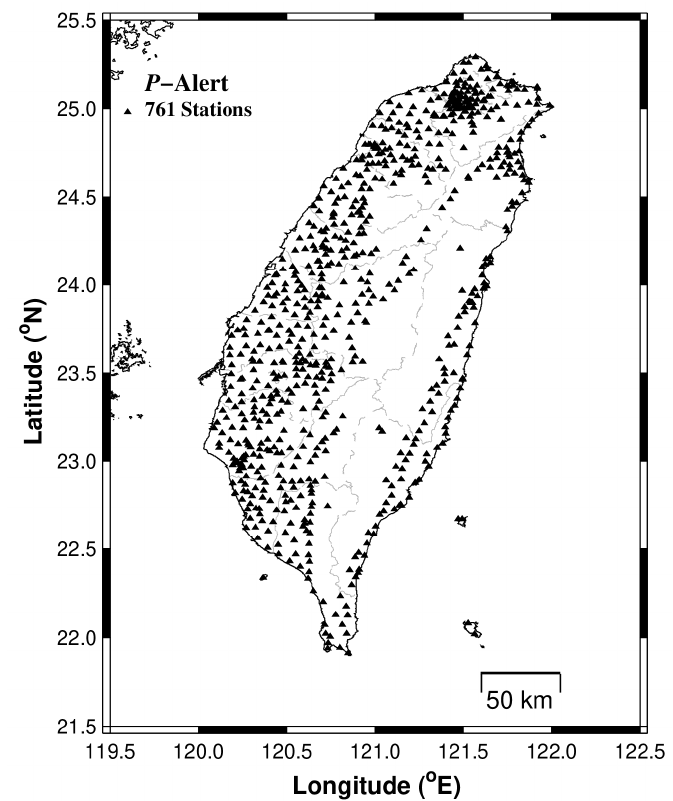
Figure 2. A map showing the distribution of P-Alert instruments in different parts of Taiwan. This dense array, consisting of 761 low-cost sensors, can act as an on-site, as well as a regional EEW system.